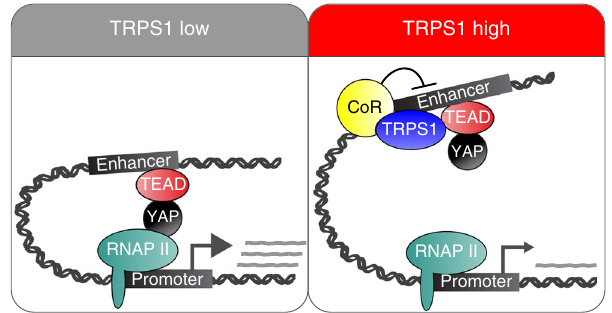
Fig. 9 Model of how TRPS1 modulates YAP/TEAD-dependent transcription.